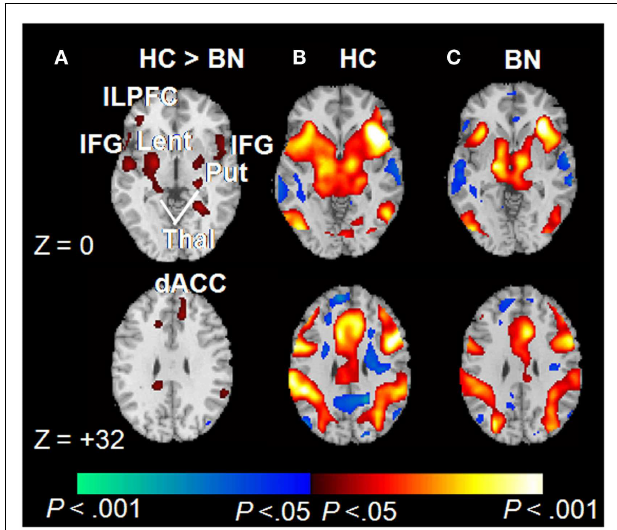
FIGURE 2 | Correct trials of the Simon spatial incompatibility task in healthy controls and individuals with BN [adapted from Marsh et al. (2009a)] . (A) Group × stimulus (congruent vs. incongruent) interactions were observed in frontostriatal regions. (B) Main effects of congruent vs. incongruent stimuli within the healthy participants. Signal increases during incongruent relative to congruent trials are shown in red. (C) Main effects of stimulus condition among those with BN. dACC, dorsal anterior cingulate cortex; ILPFC, inferolateral prefrontal cortex; IFG, inferior frontal gyrus; Lent, lenticular nucleus; Put, putamen;Thal, thalamus. Copyright © (2009) American Medical Association. All rights reserved. Adapted and reprinted, with permission, from Marsh et al. (2009a). Personal use of this material is permitted. However, permission to reuse this material for any other purpose must be obtained from the American Medical